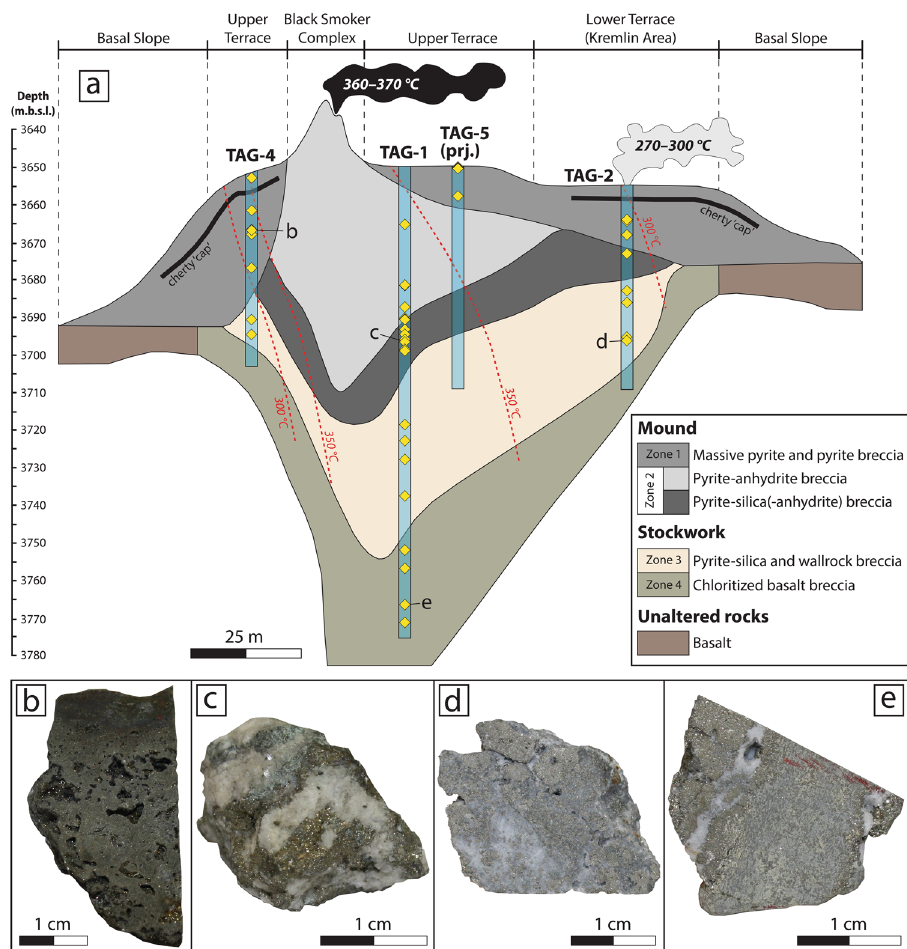
Fig. 2 Internal structure of TAG and examples of sampled sul fi de textures. a Composite section through the TAG mound and underlying stockwork drawn based on multiple drill cores in each area; TAG-5 is projected onto the section. The samples utilized in this study (yellow diamonds) encompass the main rock types from the vertical and lateral extent of TAG 19,44 : massive pyrite and pyrite breccia (types 5 and 6); pyrite-anhydrite breccia (type 7) and pyrite-silica( − anhydrite) breccia (type 8), both with abundant anhydrite veins (type 11); pyrite-silica and silici fi ed wallrock breccia (types 9 and 10a); and chloritized basalt breccia (type 10b). Vent fl uid temperatures for the Black Smoker Complex and the (now inactive) Kremlin Area are from ref. 49 and isotherms are drawn based on fl uid inclusion data 39,71 . Figure modi fi ed from ref. 52 and ref. 69 . b Massive sul fi de mineralization from the upper parts of the mound comprising fi ne-grained and porous pyrite and marcasite with local chalcopyrite. The top part of the rock piece preserves a colloform texture (TAG- 4, 957M, 14.79 m.b.s.f.). c Aggregates of pyrite and chalcopyrite (partly oxidized, greenish in photo) within a fragment of an anhydrite vein from the lower part of the mound (TAG-1, 957C, 46.69 m.b.s.f.). d Pyrite-silica breccia from the upper part of the stockwork comprising clasts of massive granular pyrite in